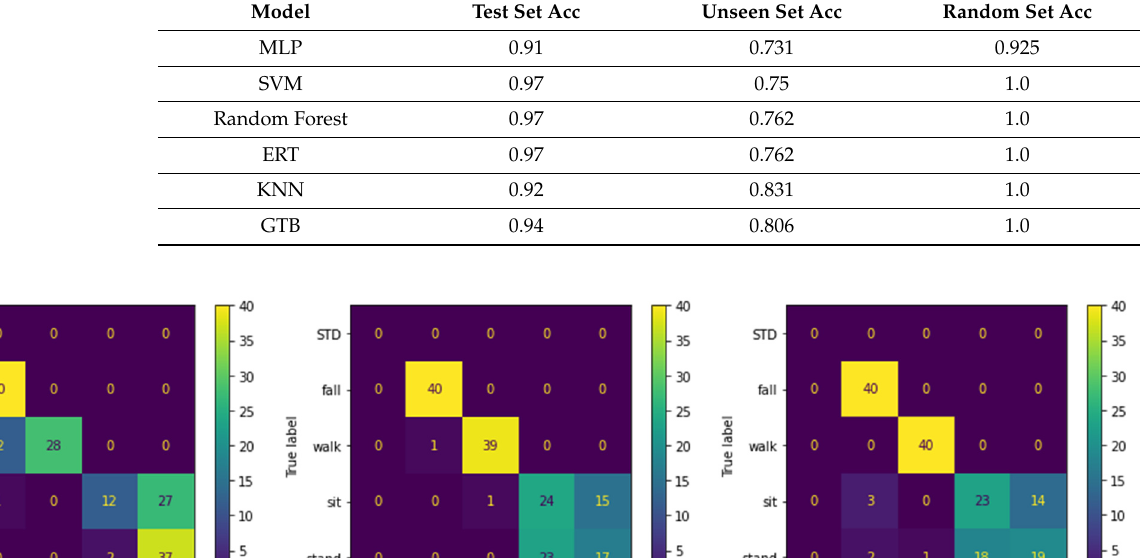
Table 3. Accuracy of classification models for Acoustic features.